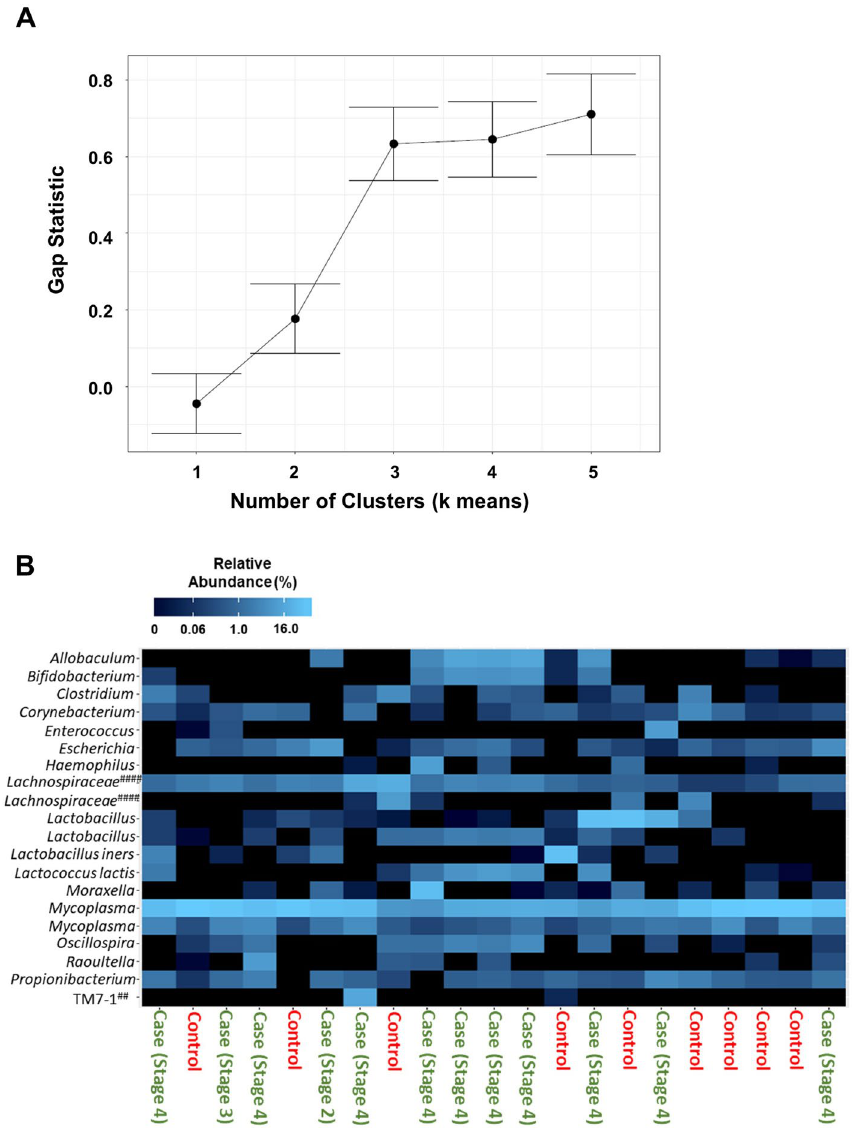
Figure 3. Examination of endometrial microbiota clustering from patients with endometriosis and symptomatic controls. ( A ) The gap statistic was calculated to give an estimation of the number of clusters found in the PCoA. Three clusters were present in the data, as indicated by the plateau in the gap statistic, which occurred at a value of 3 in this graph. ( B ) A heatmap of the top 20 bacterial taxa based on Bray–Curtis dissimilarity distance and PCoA ordination demonstrated the endometrial microbiota (columns) by disease status (Endometriosis Cases vs. Symptomatic Controls). Taxa are ordered alphabetically along the y-axis. ##: Resolved to bacterial class. ####: Resolved to bacterial